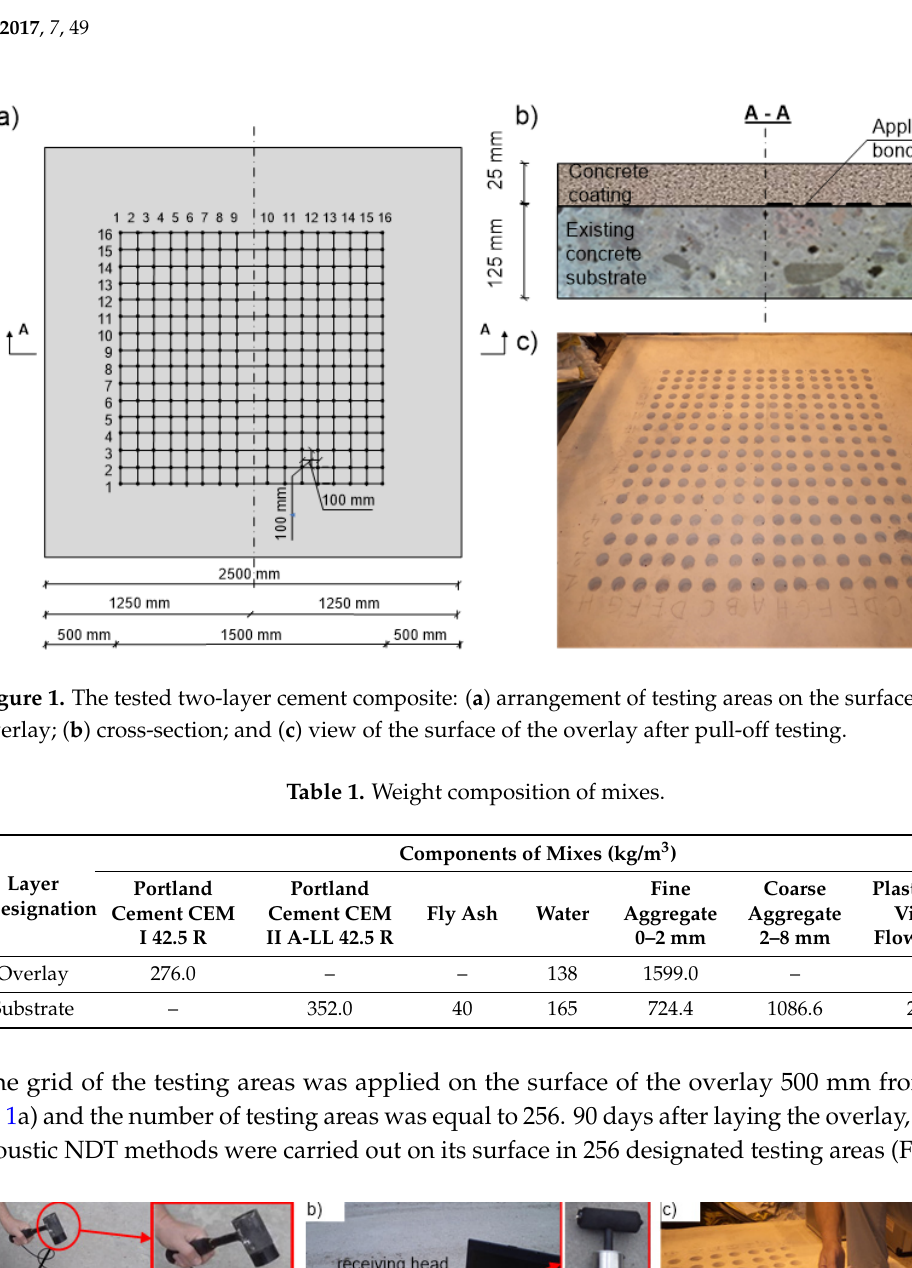
Table 1. Weight composition of mixes.